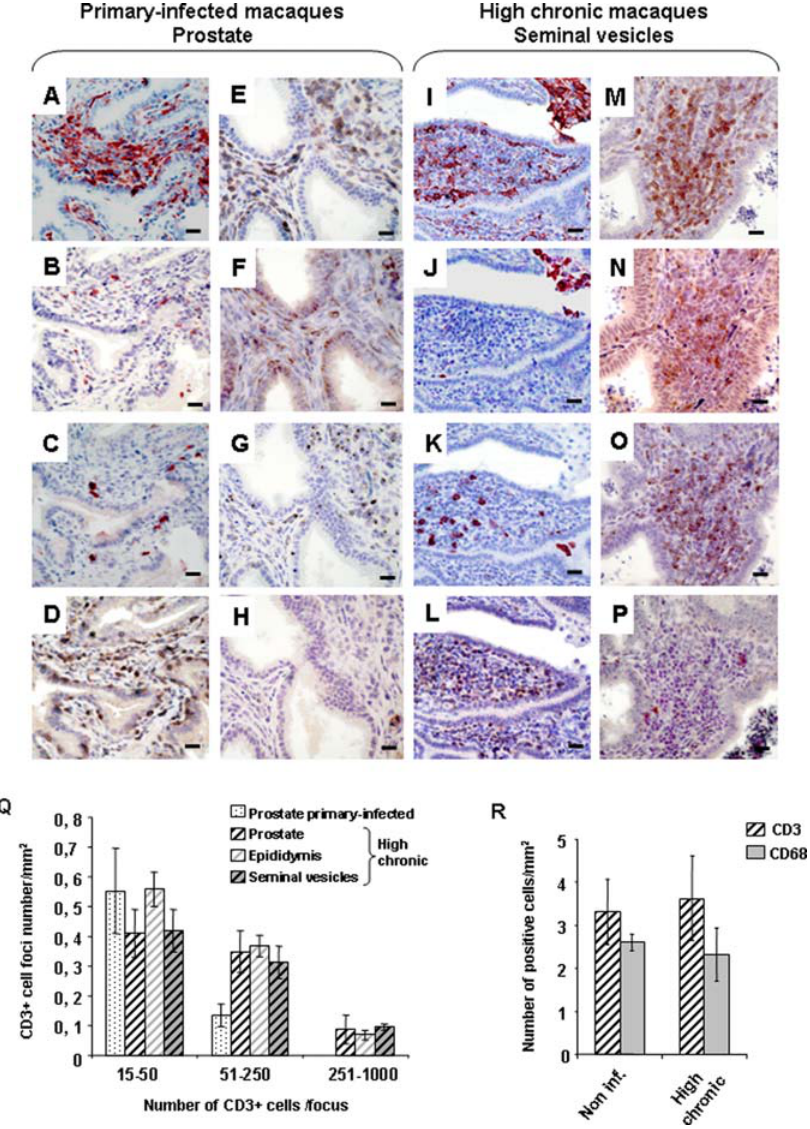
Figure 7. Characterization and semi-quantitative analysis of immune response in the infected reproductive organs. (A–P) Immunohistochemical characterization of immune cells present in the prostate of primary-infected macaques (A–H) and in the seminal vesicle of chronically infected macaques with high blood viremia (I–P): serial tissue sections (each column represents 4 serial sections) were stained with anti- HLA-DR (A, I), anti-CD68 (B, J), anti-CD20 (C, K), anti-CD3 (D, E, L, M), anti-CD4 (F, N), anti-TIA-1 (G,O) or anti-Pen5 (natural killer marker) antibodies (H,P). Note the presence of HLA-DR + and CD68 + cells in the seminal vesicle lumen (I, J). Scale bars=20 m m. (Q) Semi-quantitative analysis of CD3 + cell foci in the male genital organs of infected macaques. The number of CD3 + cells in each focus was determined using the Cast software. The number of foci in each category (15–50 cells, 51–250 cells, 251–1000 cells) was counted on whole sections of epididymis, seminal vesicles and prostate from chronically-infected macaques with high PVL, and prostate from primary infected macaques. (R) Quantitative analysis of CD68 + and CD3 + stained positive cells in the testes of non-infected macaques (non inf.) and macaques chronically infected with SIV and displaying high PVL (high chronic).